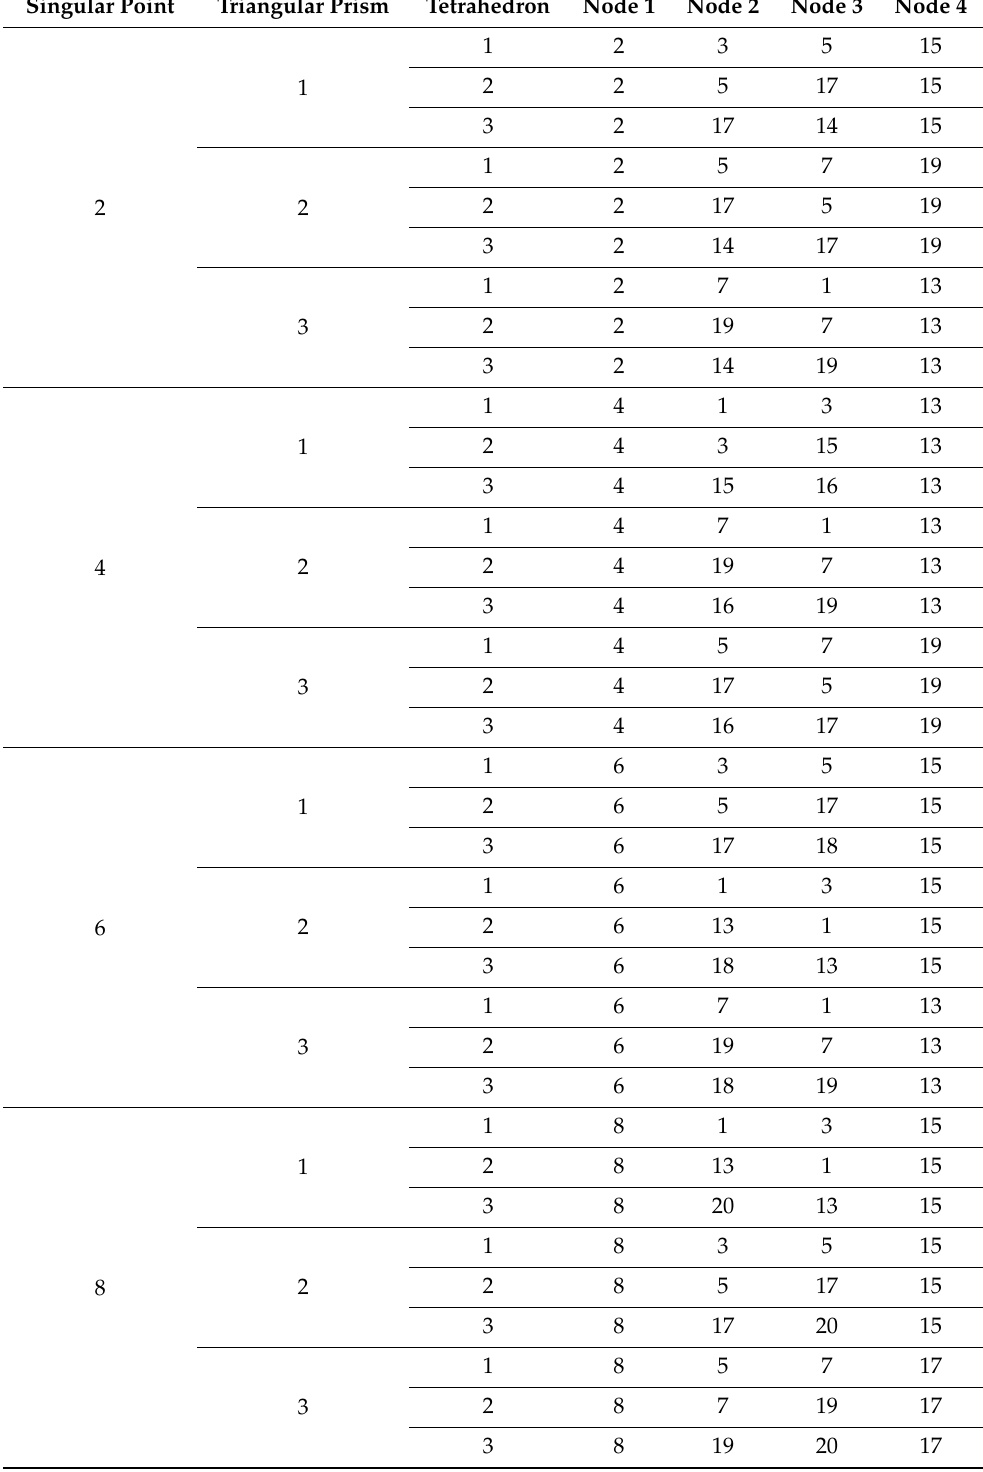
Table 4. A subdivision of each triangular prism into three tetrahedral subcells at each singular point (cid:48) after a subdivision of Ω f into three triangular prisms (see Figure 5b,c). The singular point is located at the midside of the hexahedral element shown in Figure